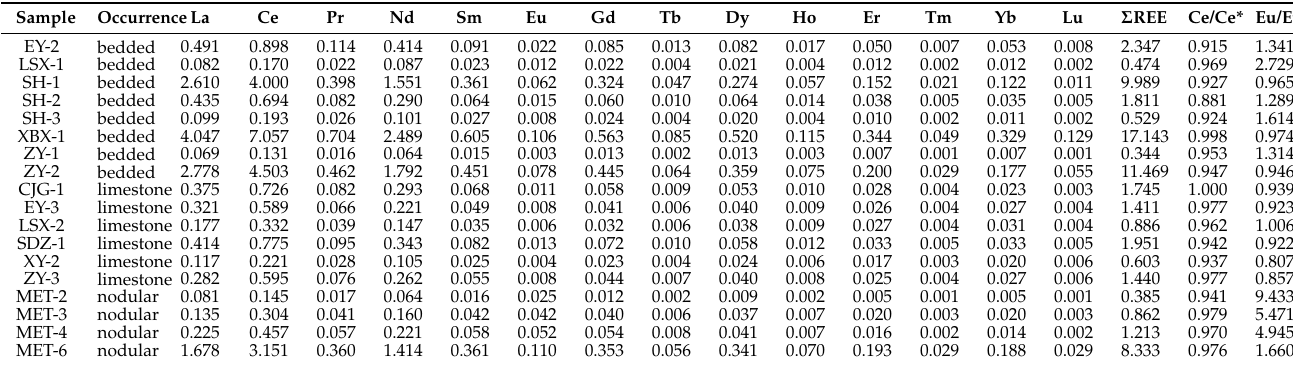
Table 3. REE analysis results of the Maokou cherts and limestones in the Sichuan Basin